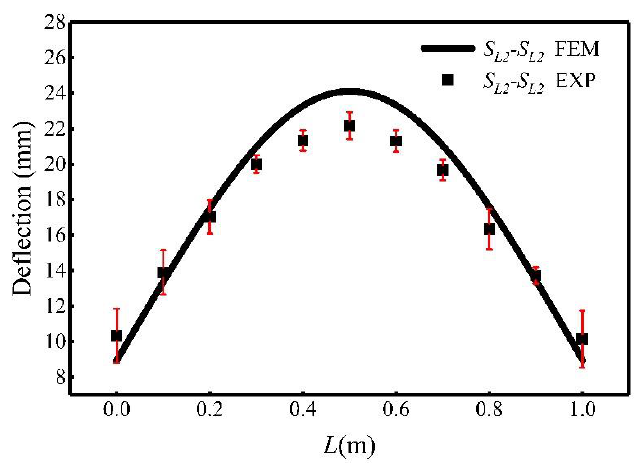
Figure 11. Comparison of plate longitudinal bending deformation.